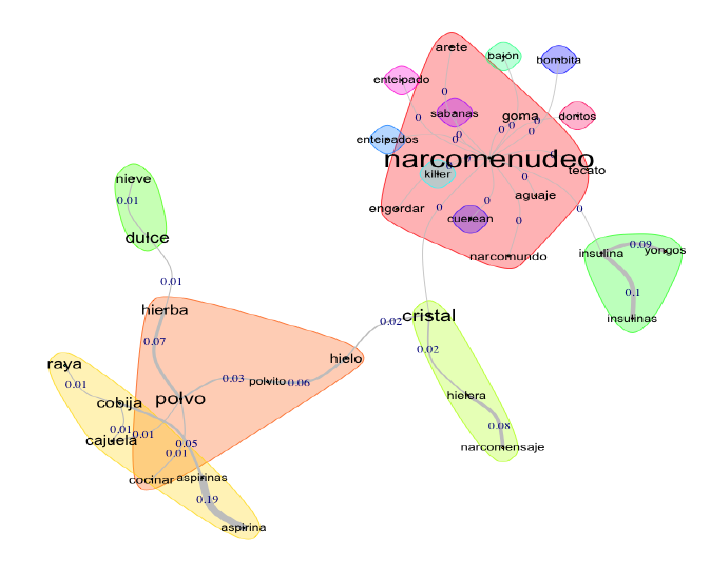
Figure 3. Sample of common communicative frames.